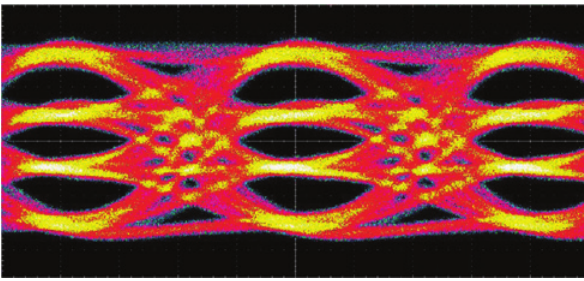
Figure 16: SM-VCSEL 50 Gb/s optical eye diagram without equaliza- tion or pre-emphasis.